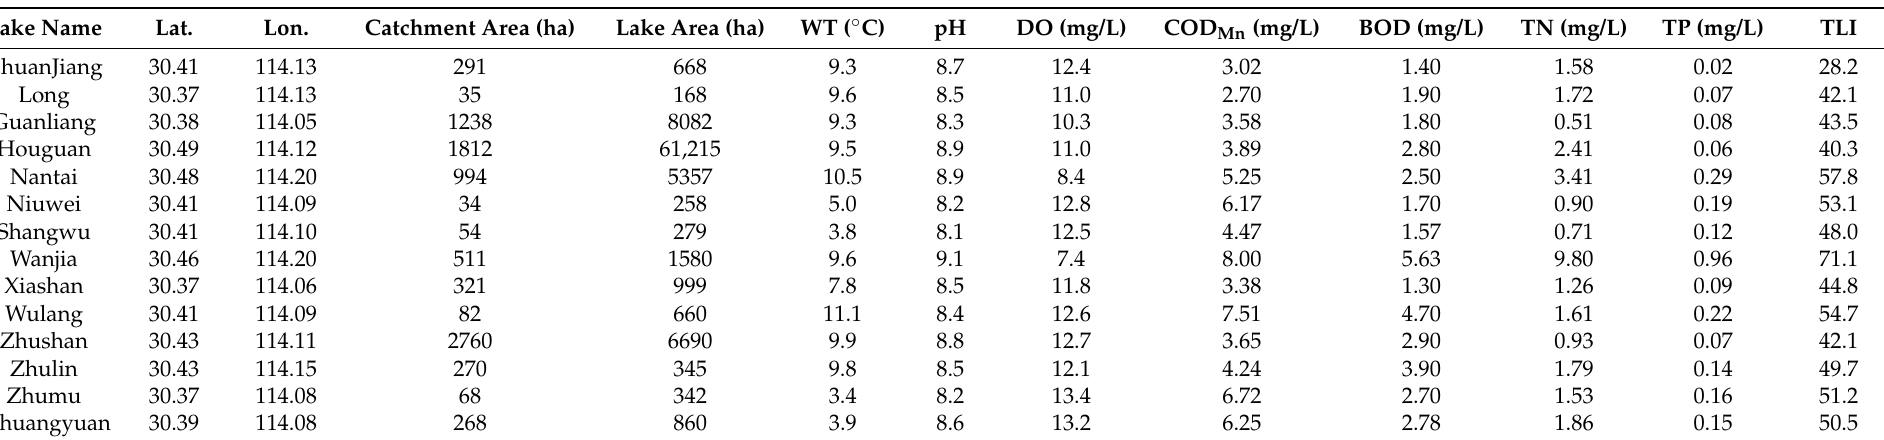
Table 1. The physicochemical properties of water in the urban lakes analyzed in this